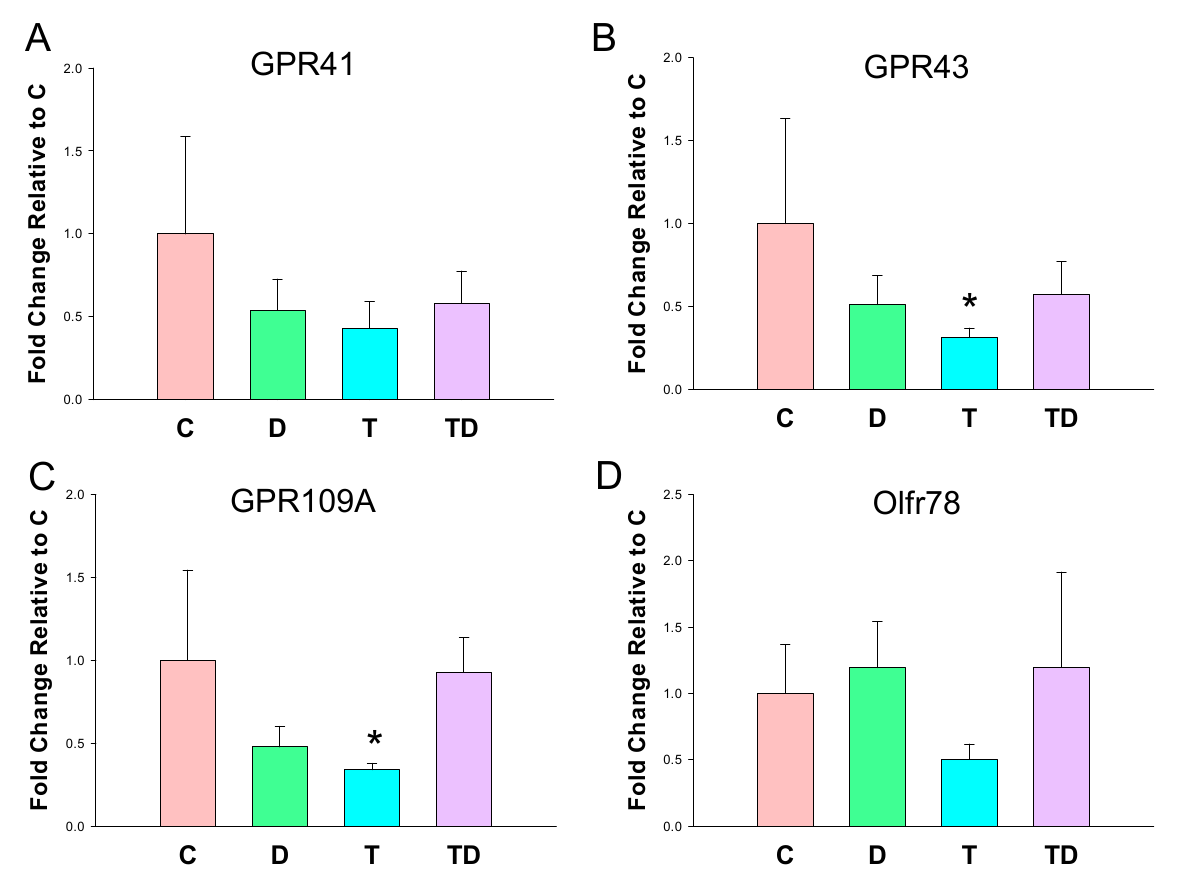
Figure 2. Effect of 3,3-Dimethyl-1-butanol (D) and 2,3,7,8-tetrachlorodibenzo-p-dioxin (T) on short chain fatty acid (SCFA) receptors. The mRNA expression of SCFA receptor ( A ) G protein-coupled receptor 41 (GPR41), ( B ) GPR43, ( C ) GPR109A, and ( D ) olfactory receptor 78 (Oflr78) in offspring kidneys. N = 8 per group; * p < 0.05 vs. C.